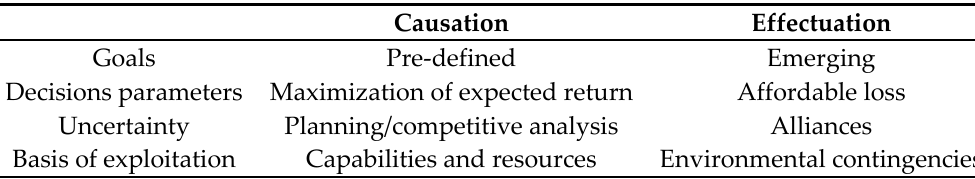
Table 1. Differences between causation and effectuation logics